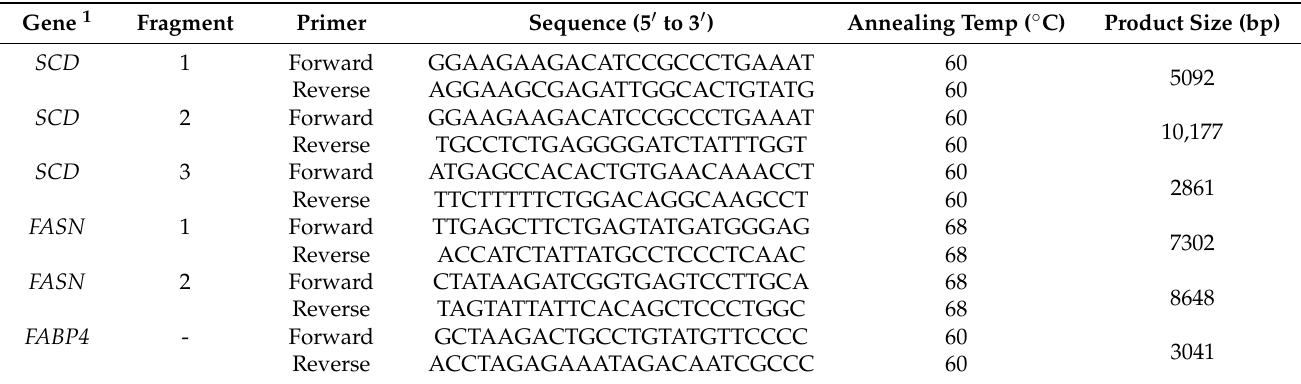
Table 1. Primer sequences for target gene